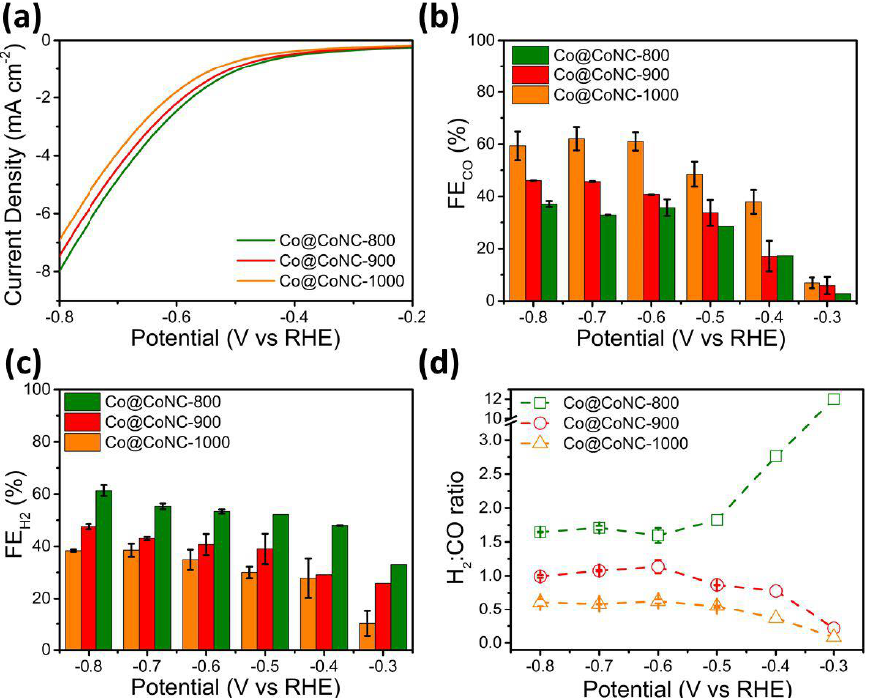
Figure 13. Modification of syngas ratio using active site manipulation. ( a ) Linear sweep voltammetry, ( b ) FE CO , ( c ) FE H2 , and ( d ) H 2 /CO ratio with applied potential for the prepared catalysts. Reproduced from [82]. Copyright (2020), with permission from the American Chemical Society. Some of the recent progresses on syngas production/conversion by utilizing magnetic nanomaterials are compared and shown in Table 1. Table 1. Various magnetic materials and their utilization for syngas production/conversion.